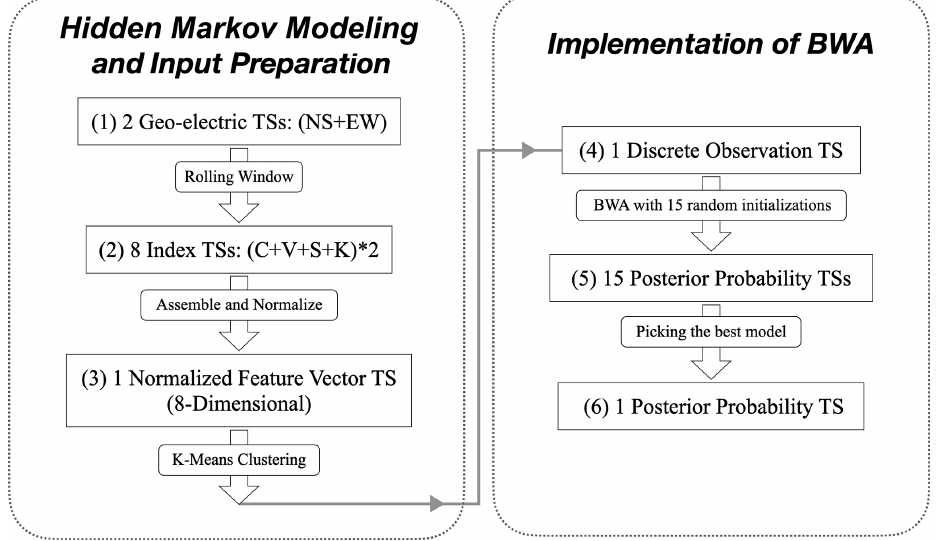
Figure 5. Flowchart summarizing the procedures of obtaining the optimal posterior probability TS ˜ P 1 from the data of one GEMS